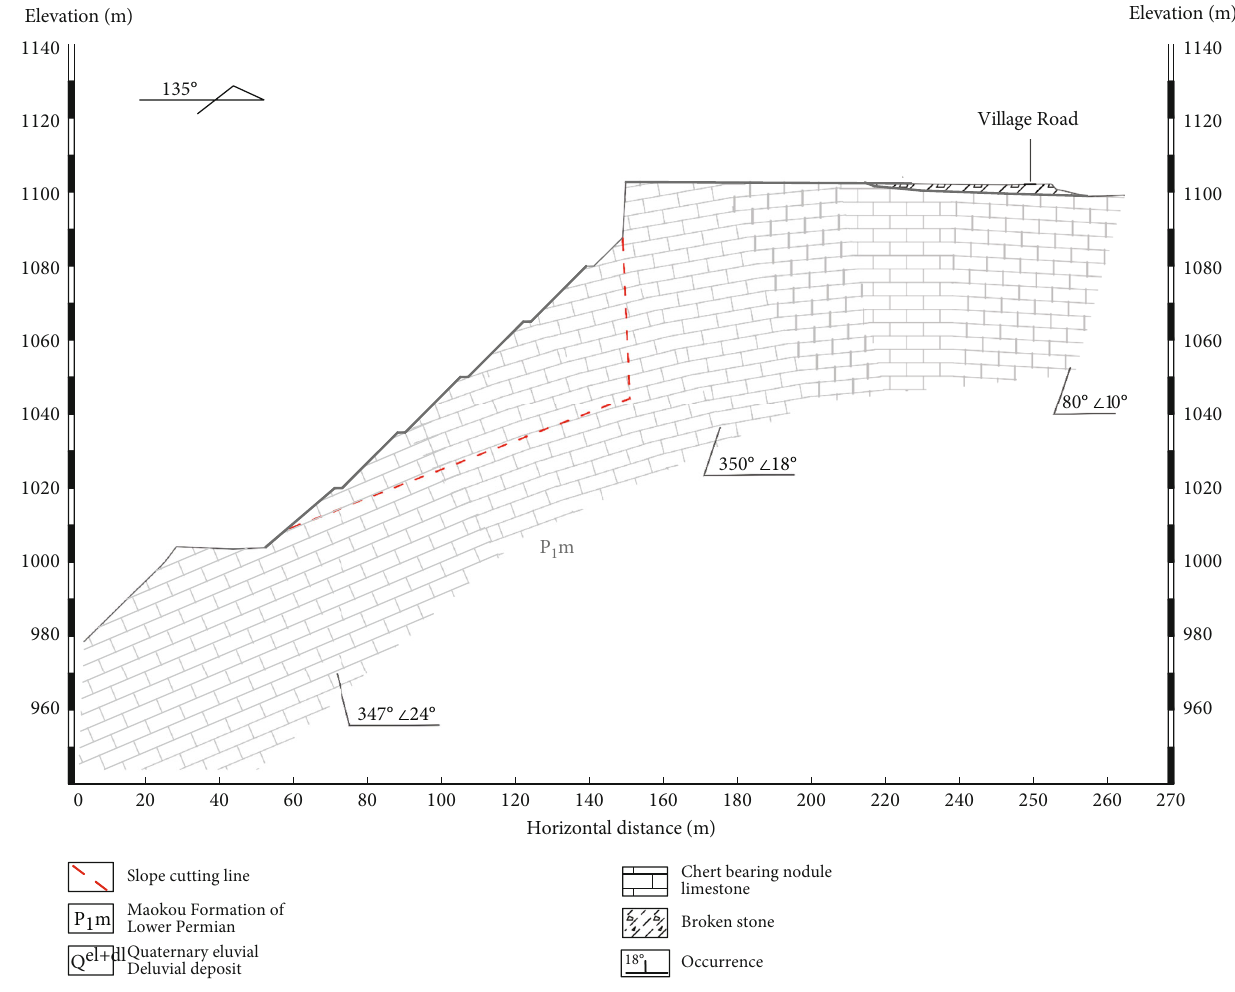
Figure 15: Stability calculation pro fi le of 1-1 ′ section after slope cutting and shaping. Table 2: Calculation results of retaining